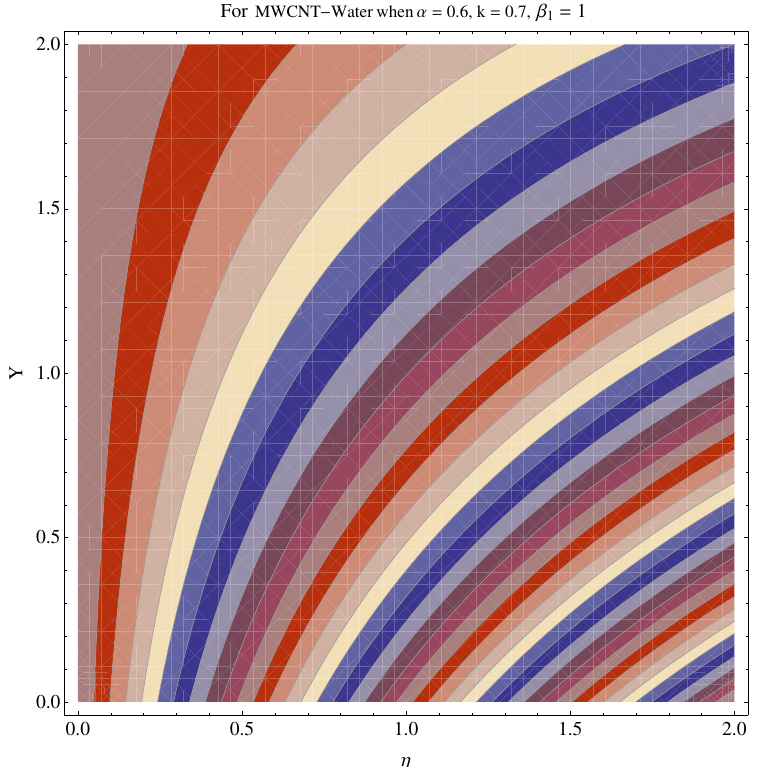
Figure 18. Contour graph at β 1 = 1.0 for MWCNT at larger k